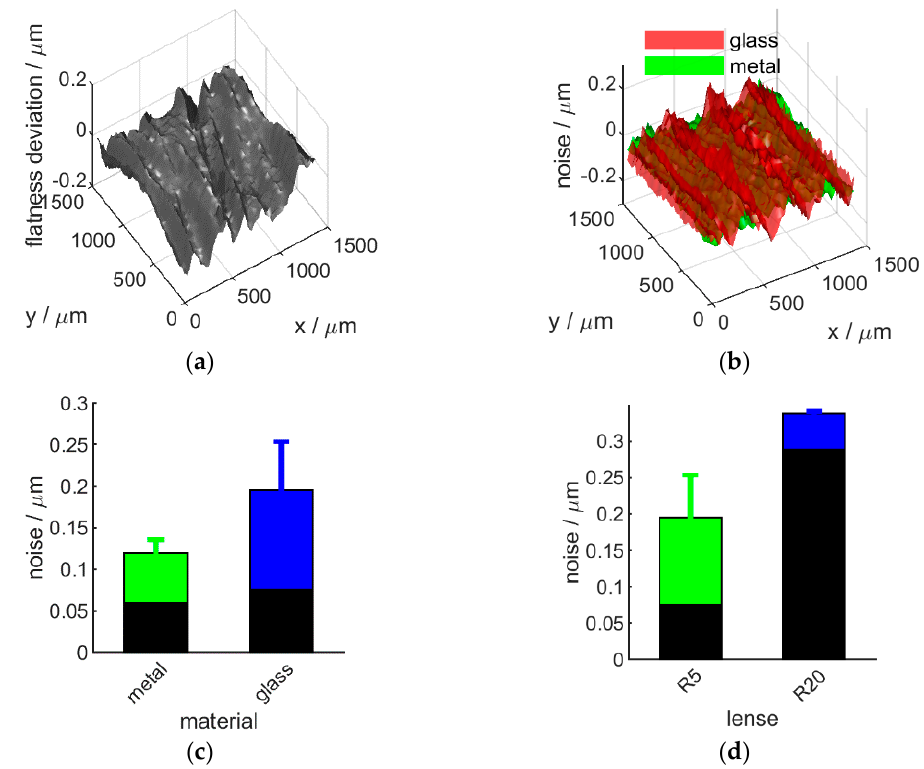
Figure 4. Flatness deviation ( a ), surface noise distribution ( b ) and noise level for different sample material ( c , R5 optics) and optics ( d , glass surface) used. Bars are the mean and the single sided positive error-bars represent the standard deviation over 11 repetitions. Black bars represent noise evaluated on the average surface (averaging the 11 single measurements).